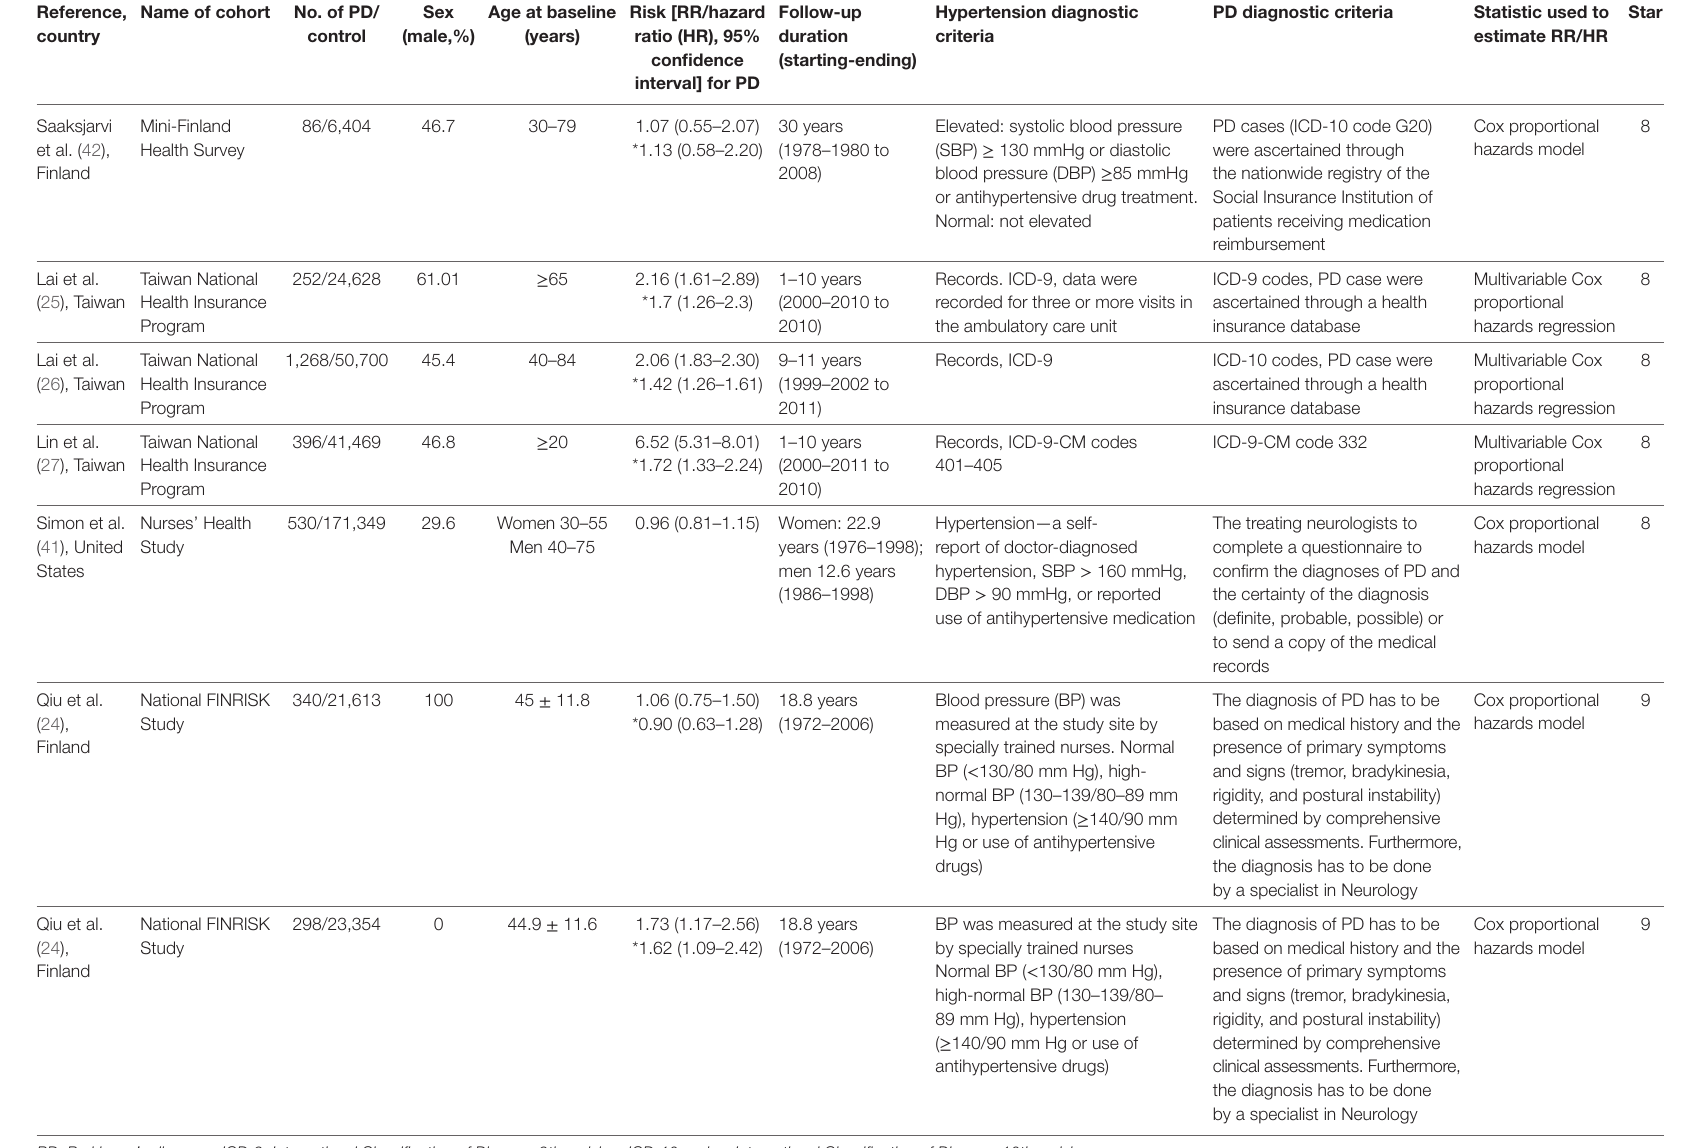
taBLe 1 | Characteristics of cohort studies included in the meta-analysis. Reference,